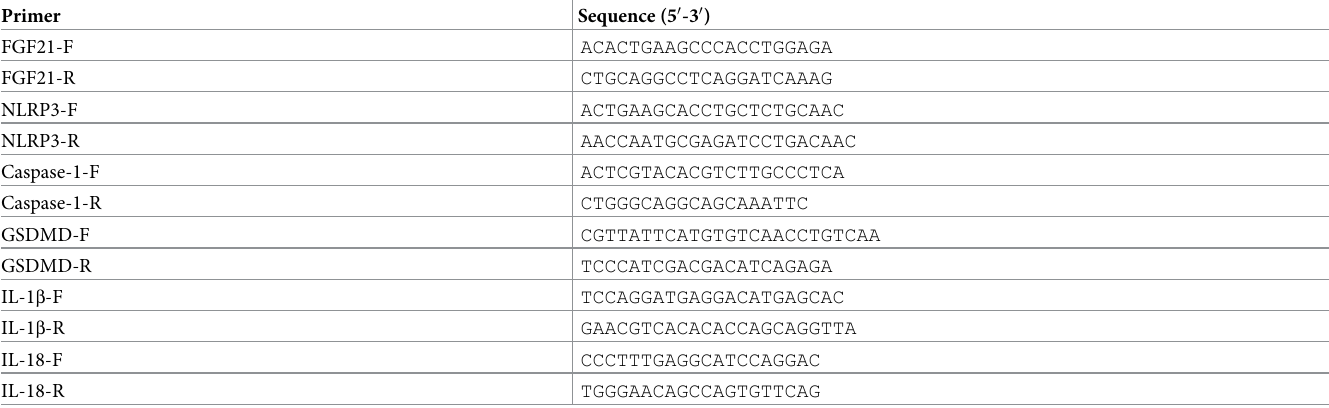
Table 1. Forward/reverse (F/R) primer